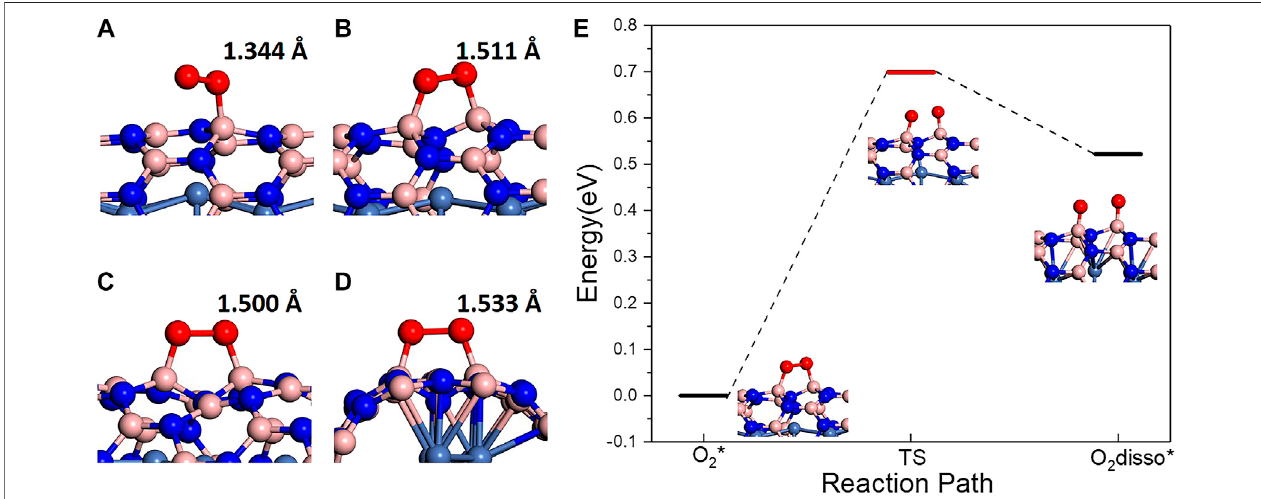
FIGURE 2 | (A, B) Structures of superoxo and peroxo chemisorbed O chemisorbedO